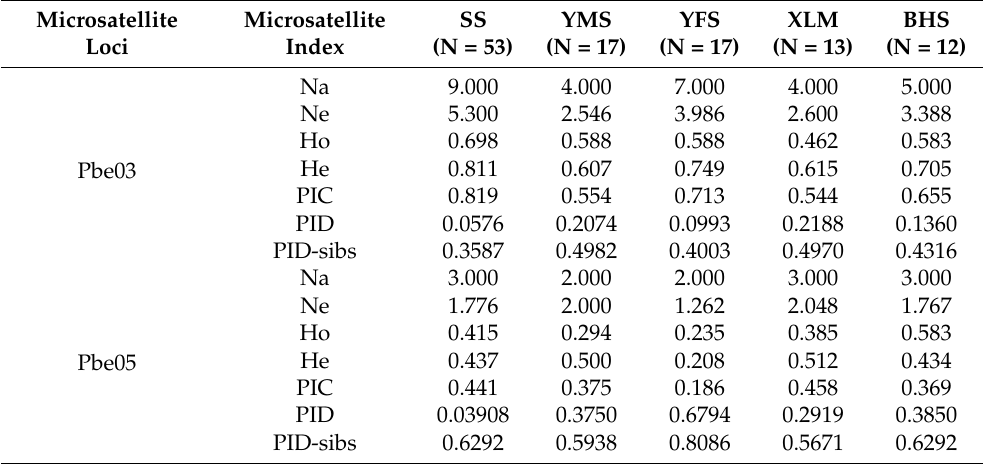
Table 3. Genetic diversity and probability of identity of six microsatellite loci detected in leopard cat subpopulations in the five sampling